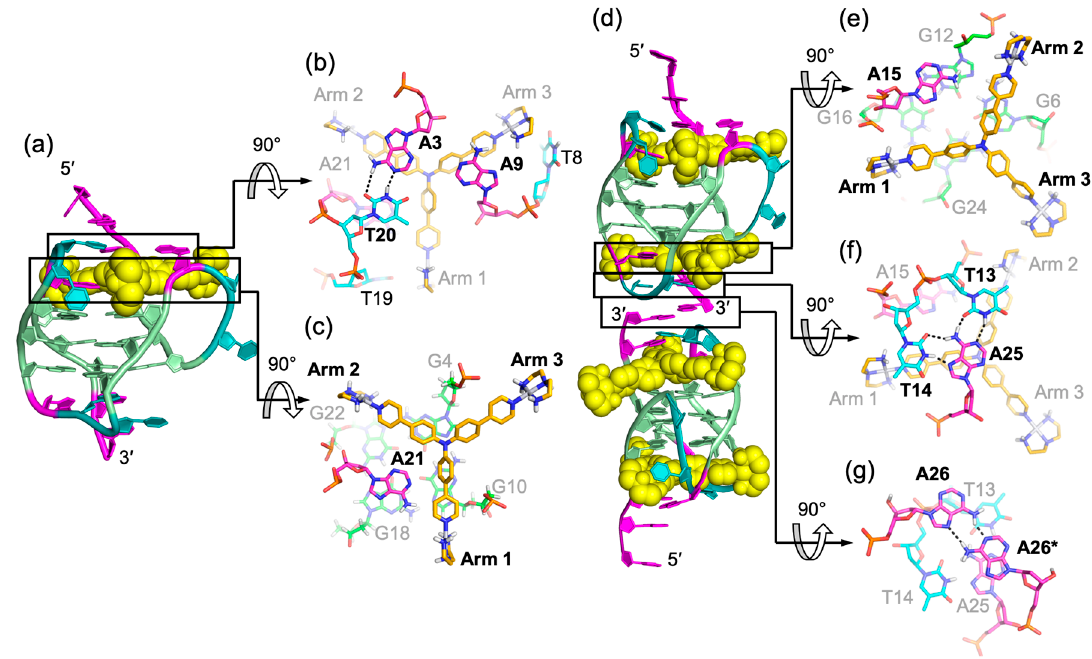
Figure 6 . Solution structure of 1:1 and 4:2 Pt-tripod/hybrid-1 G-quadruplex complexes (PDB ID: 5Z80 and 5Z8F). ( a ) Cartoon representation of 1:1 Pt-tripod/hybrid-1 complex. Different nucleotides are marked as follows: Thymine, cyan; adenine, pink; and guanine, green. The Pt-tripod molecule is shown as the yellow spheres. (b – c) Top views of the A3:A9:T20 triad plane ( b ) and Pt-tripod:A21 plane at 5 ′ site ( c ). ( d ) Cartoon representation of 4:2 Pt-tripod/hybrid-1 complex. (e – g) Structural details of the 3 ′ site binding pocket. Bottom views of the Pt-tripod:A15 plane ( e ), T13:T14:A25 triad plane ( f ), and the A26:A26* (A26 from each hybrid-1) base pair ( g ). Potential hydrogen bonds are shown in black dashed lines.